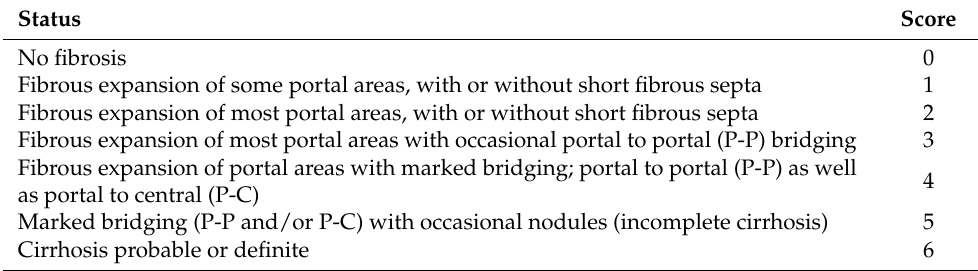
Table 1. Ishak fibrosis staging.